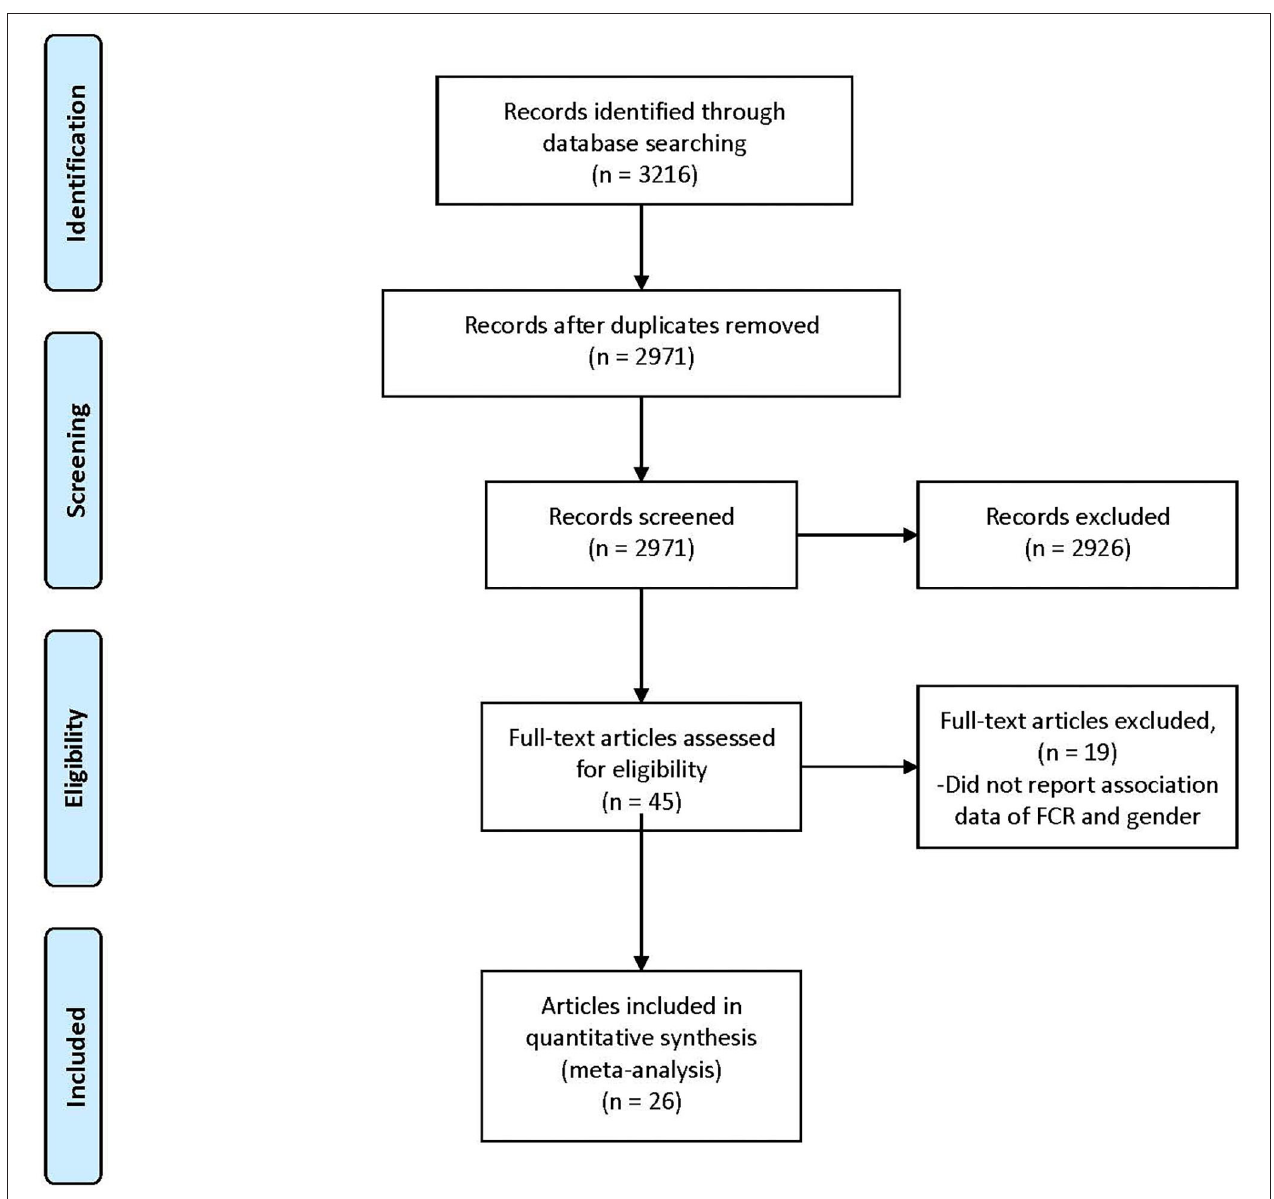
FIGURE 1 | Preferred reporting items for systematic reviews and meta-analyses (PRISMA)